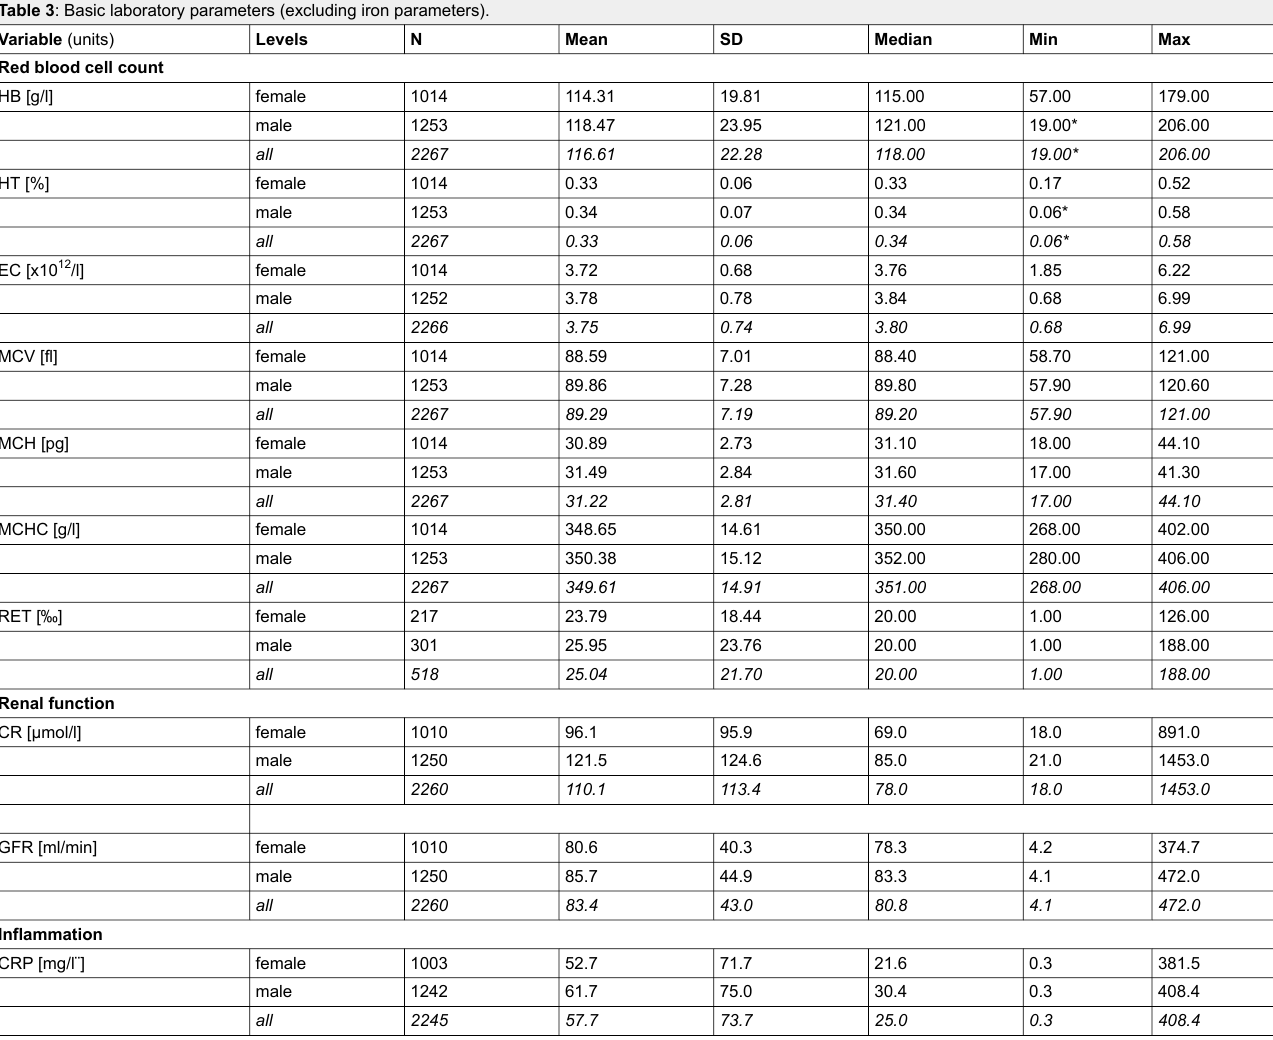
Table 3 : Basic laboratory parameters (excluding iron parameters). Variable (units)